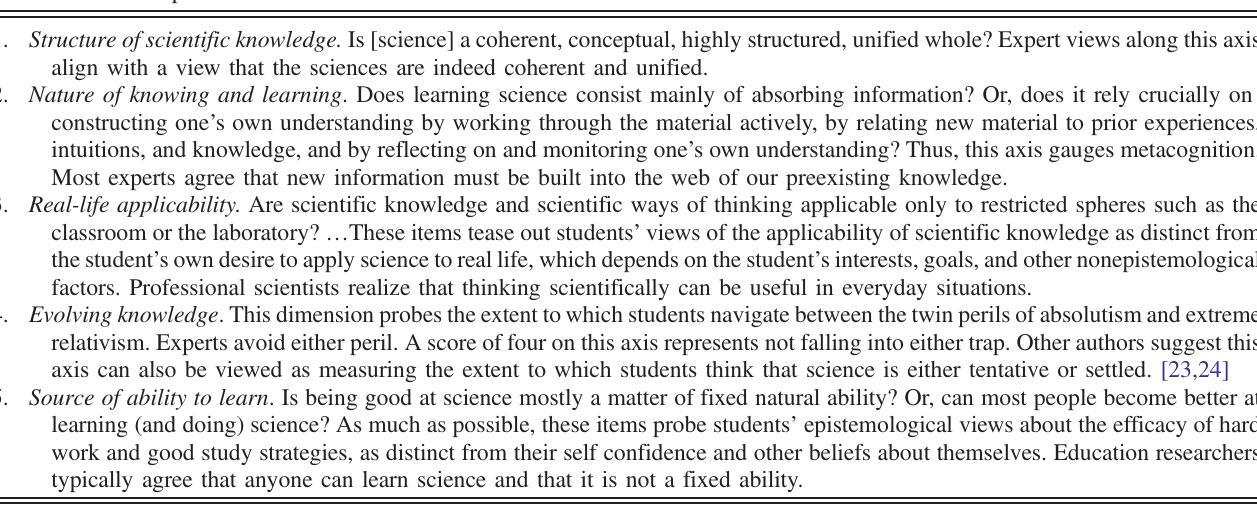
TABLE I. Description of EBAPS